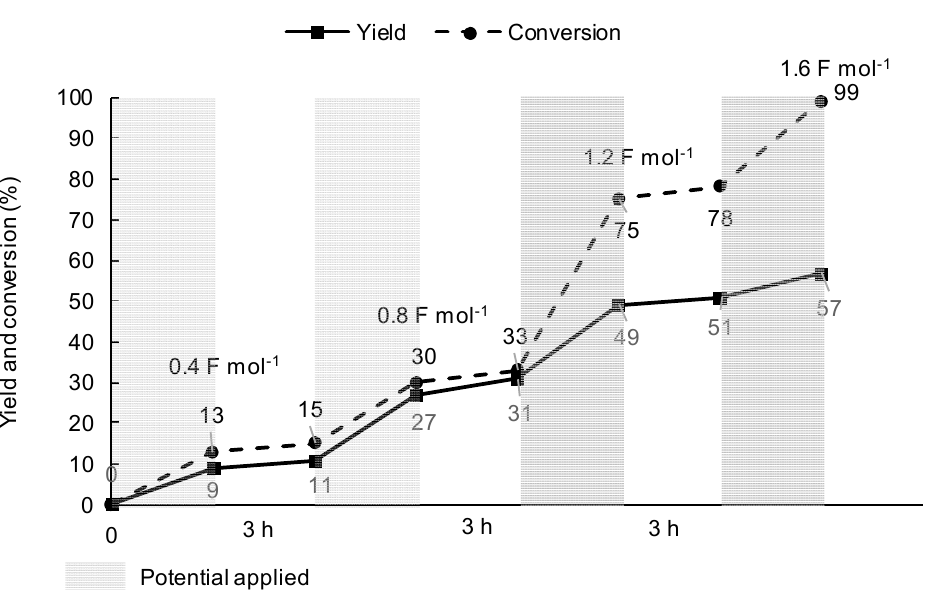
Figure 5. Yield of 3a and conversion of 1a on the interval-electrolysis.